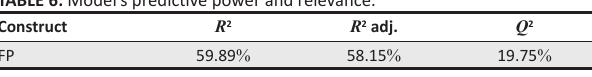
TABLE 6: Model’s predictive power and